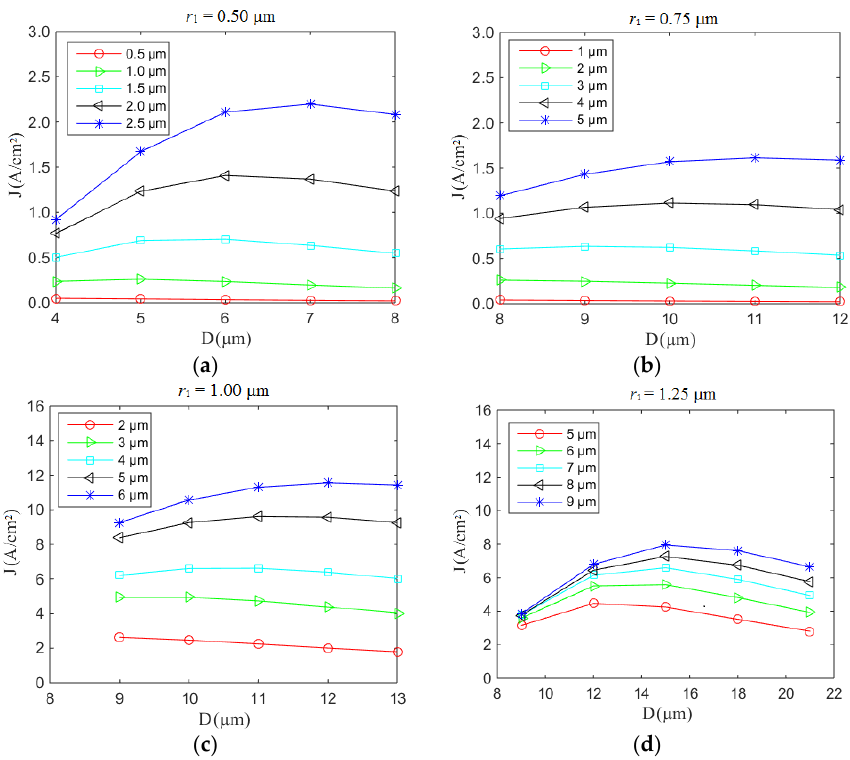
Figure 4. Field emission current density as a function of h and D . Under low-bias (35 V), ( a ) r 1 = 0.50 μm and ( b ) r 1 = 0.75 μm; under high-bias (50 V), ( c ) r 1 = 1.00 μm and ( d ) r 1 = 1.25 μm.